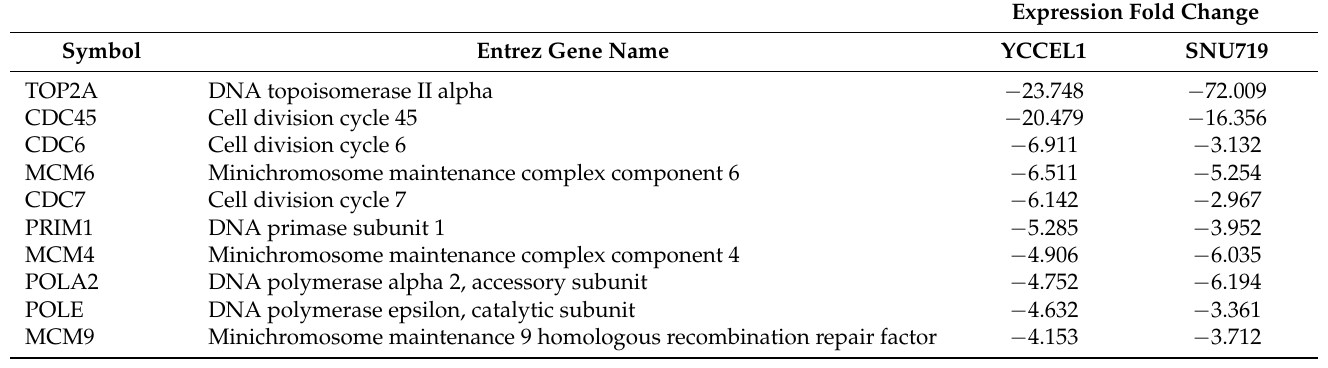
Table 2. Change of gene expression of pathway “cell cycle control of chromosomal replication”.